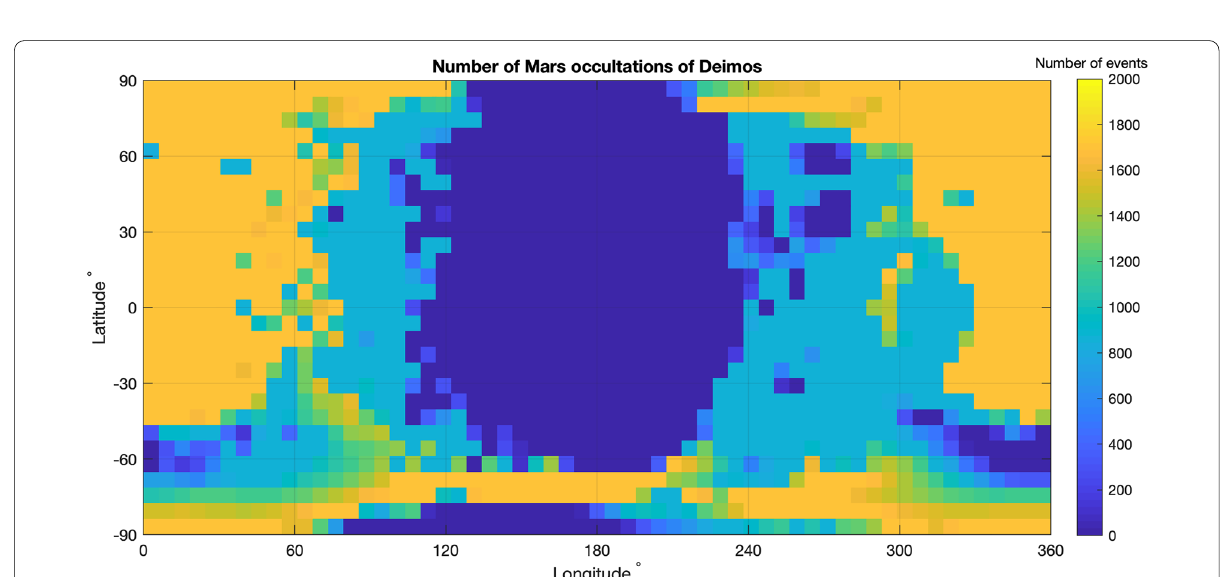
Fig. 11 Map of Phobos. Number of Mars occultations of Deimos during the period 1 Jan 2030 – 18 Nov